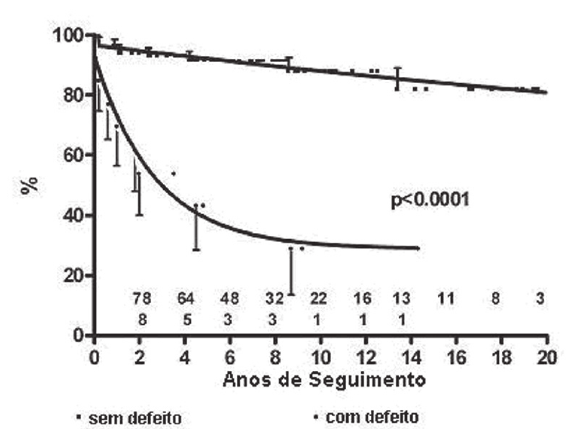
Fig. 2 - Influência da presença de defeitos residuais ou de próteses valvares na probabilidade de sobrevida de crianças submetidas à estimulação cardíaca permanente pela via endocárdica transfemoral. Círculos = correções paliativas/correções completas com defeitos residuais ou próteses valvares; quadrados = correçõescompletas sem defeitos residuais ou próteses valvares